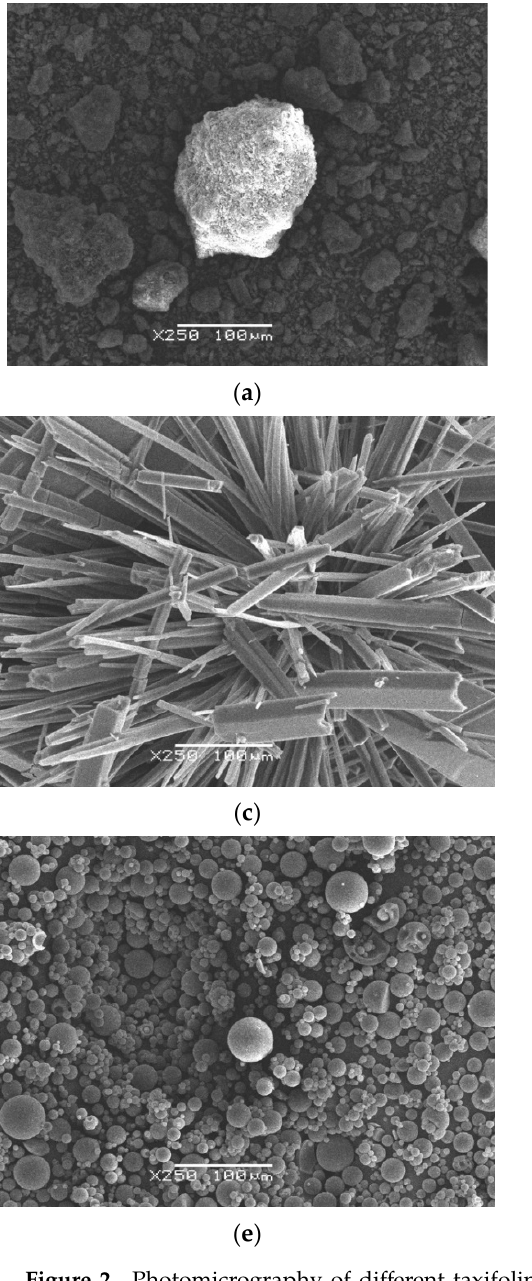
Figure 2. Photomicrography of different taxifolin forms: ( a ) raw taxifolin at 250× magnification; ( b ) raw taxifolin at 10,000× magnification; ( c ) taxifolin microtubes at 250× magnification; ( d ) taxifolin microtubes at 10,000× magnification; ( e ) taxifolin microspheres at 250× magnification; ( f ) taxifolin microspheres at 10,000× magnification.